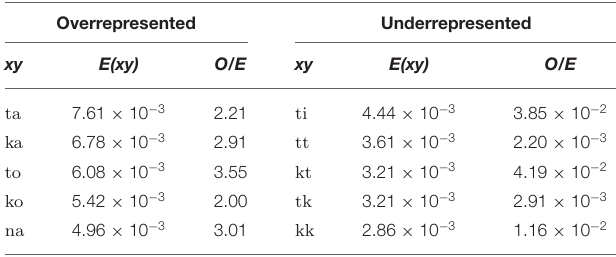
TABLE 1 | Five over-/underrepresented biphones in Japanese with highest expected values.